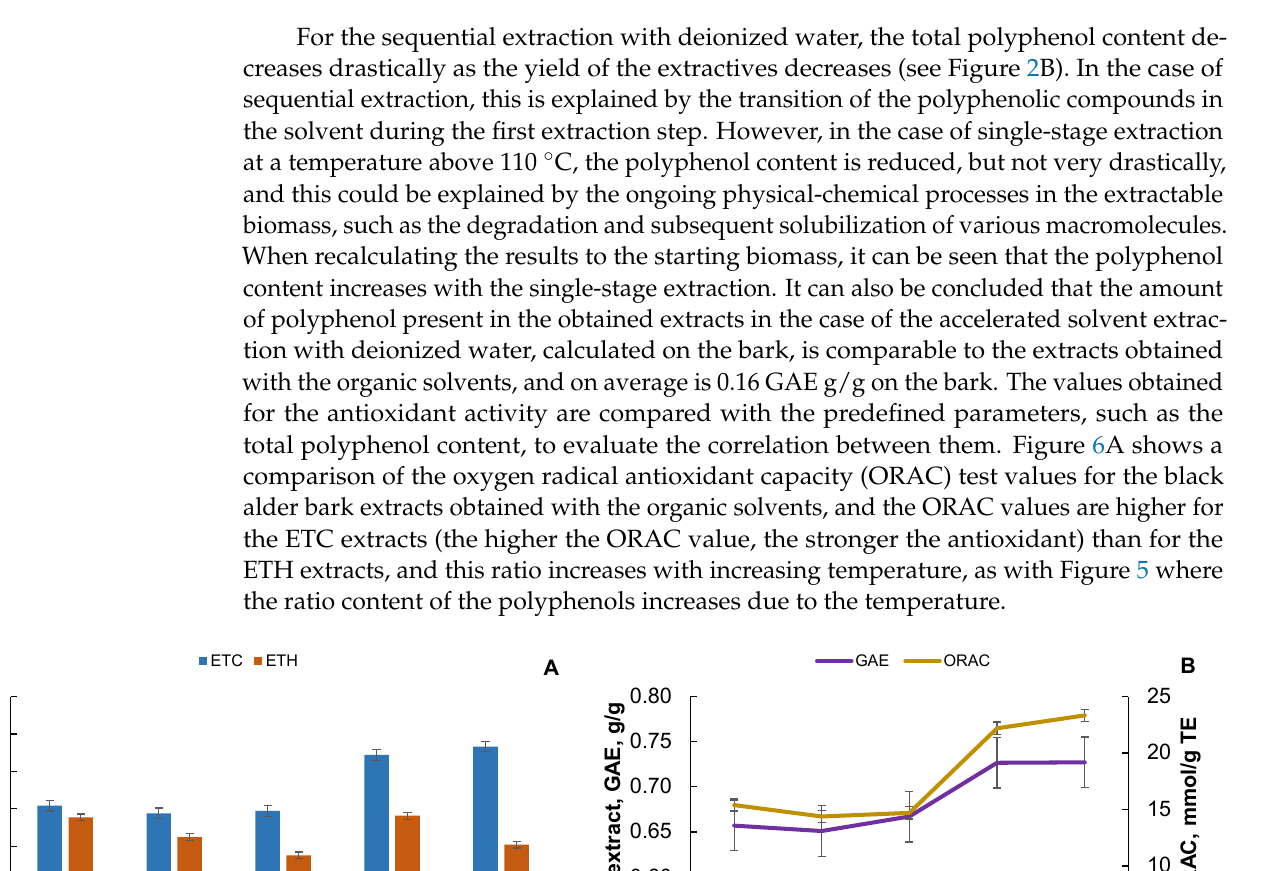
Figure 5. Black alder bark accelerated solvent extraction (single step and sequential) with deionized water total polyphenol content in the extracts and the bark depend on the temperature at predefined extraction parameters. Data is shown as mean ( n = 4) values ± standard deviation. Kruskal–Wallis test, p < 0.05.